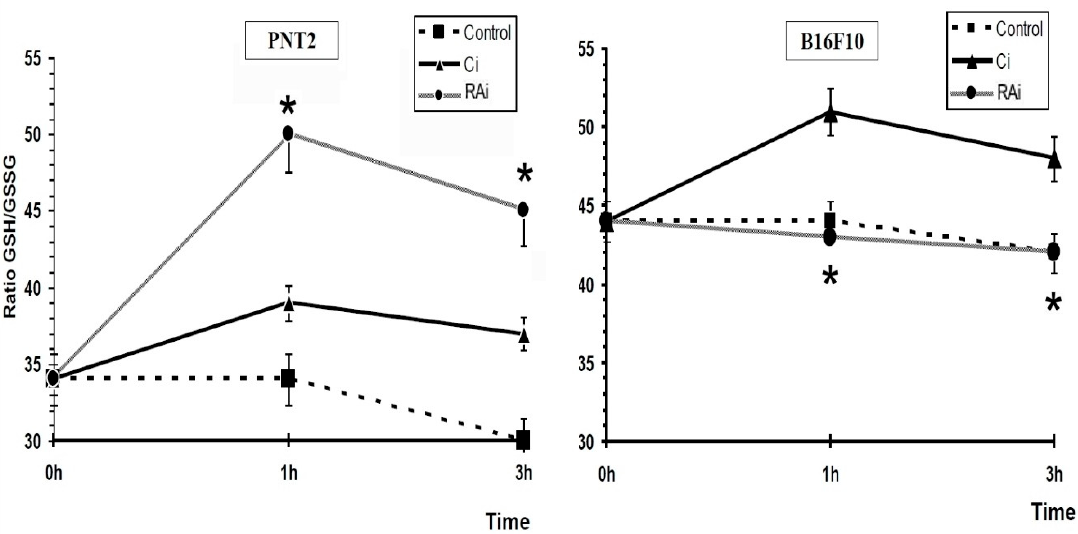
Figure 5. GSH / GSSG ratio in PNT2 and B16F10 cells determined at 1h and 3h after exposure to 20 Gy of X-rays (C—controls, Ci—irradiated controls, RAi—irradiated cells treated with RA dissolved in PBS, * p < 0.001). Data are the mean ± standard error of eight independent experiments.